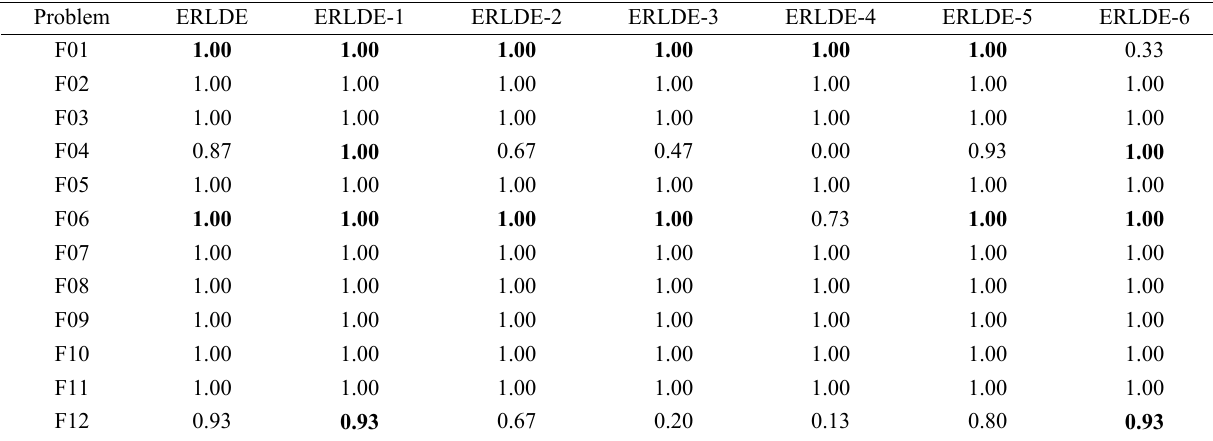
Table A5 Comparison between ERLDE and other ERLDE variants with respect to SR